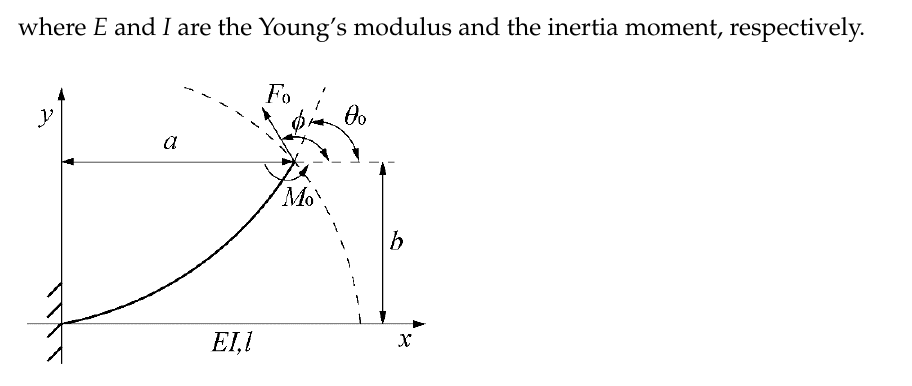
Figure 2. Large deflection of a cantilever beam subjected to a combined end force and moment.